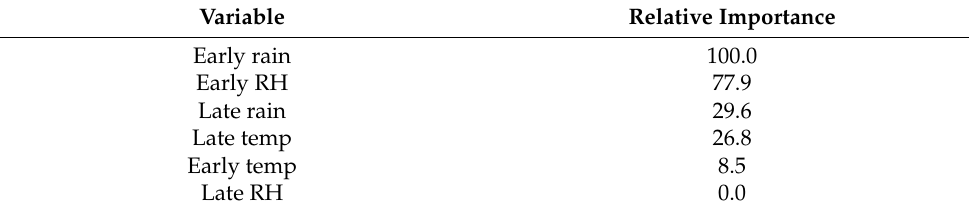
Table 4. The relative importance of variables in the random forest mode (RH, relative humidity).